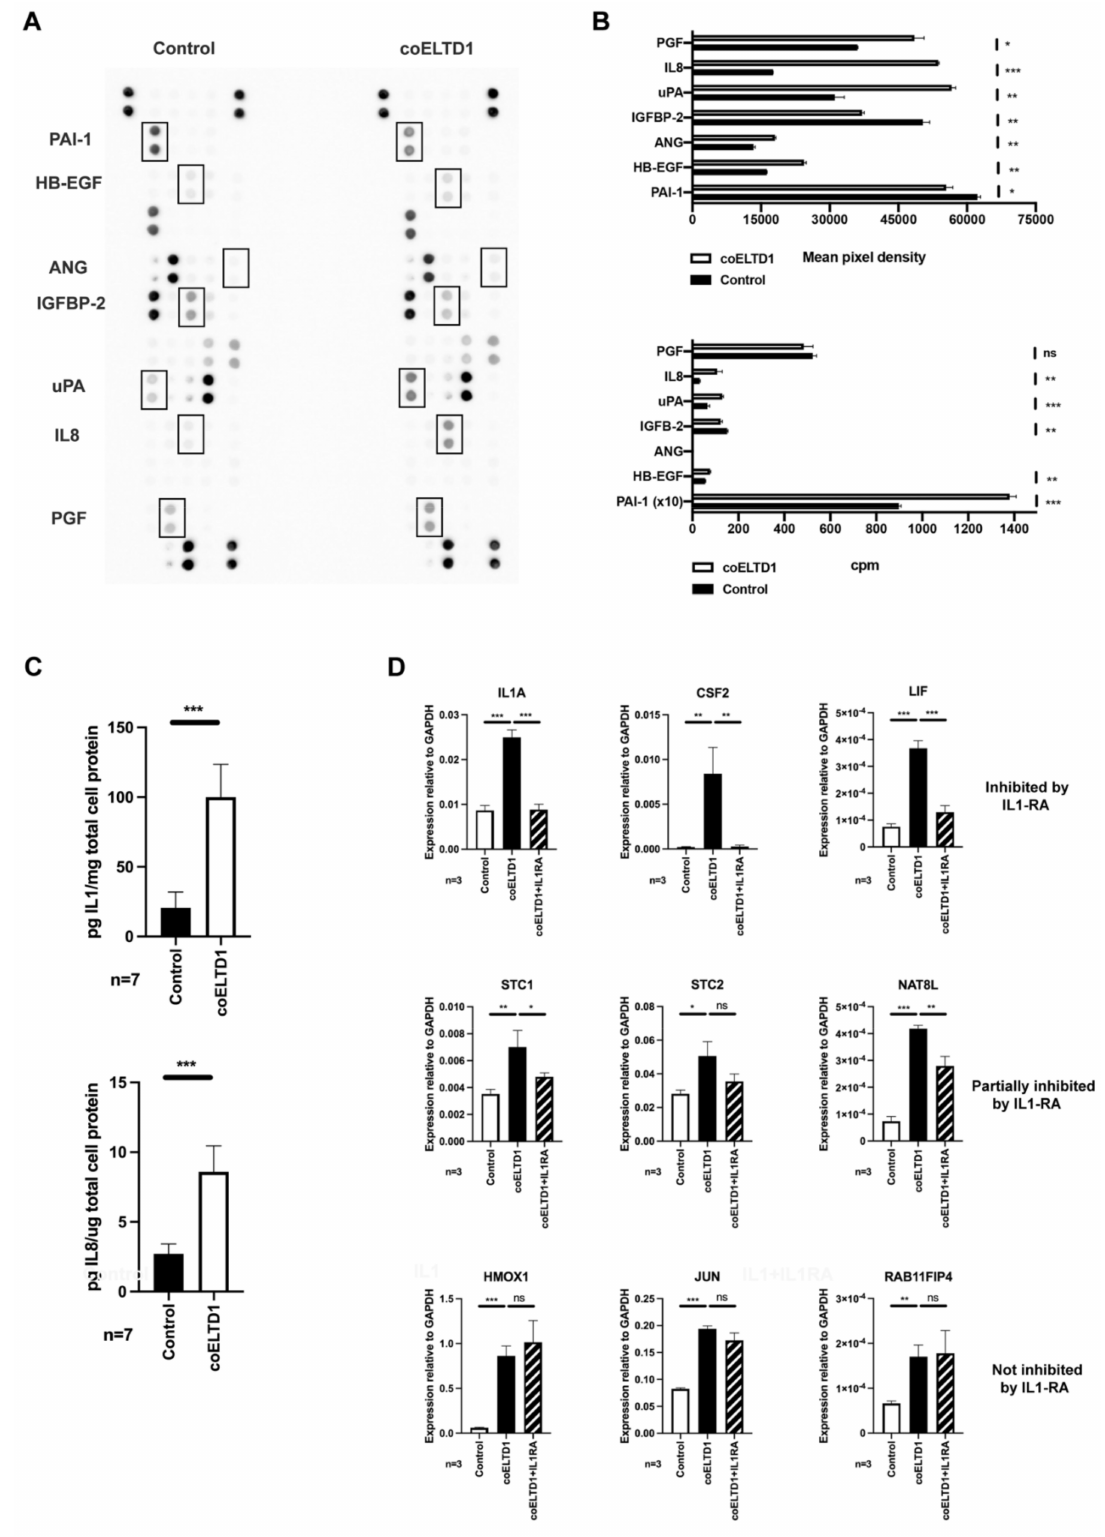
Figure 6. Pro-angiogenic secreted factors are released by coELTD1 expressing cells, including IL1. ( A ) ProteomeProfiler TM Angiogenesis Array (R&D Systems) using supernatant collected from control and coELTD1 HUVEC collected at 120 h. ( B ) Quantification of the Angiogenesis array and comparison with RNA expression level. ( C ) Quantification of IL1 and IL8 secretion at 120 h using ELISA. ( D ) Expression of IL1 target genes upon IL1 treatment +/ − IL1-receptor antagonist. * p <0.05; ** p <0.005; *** p